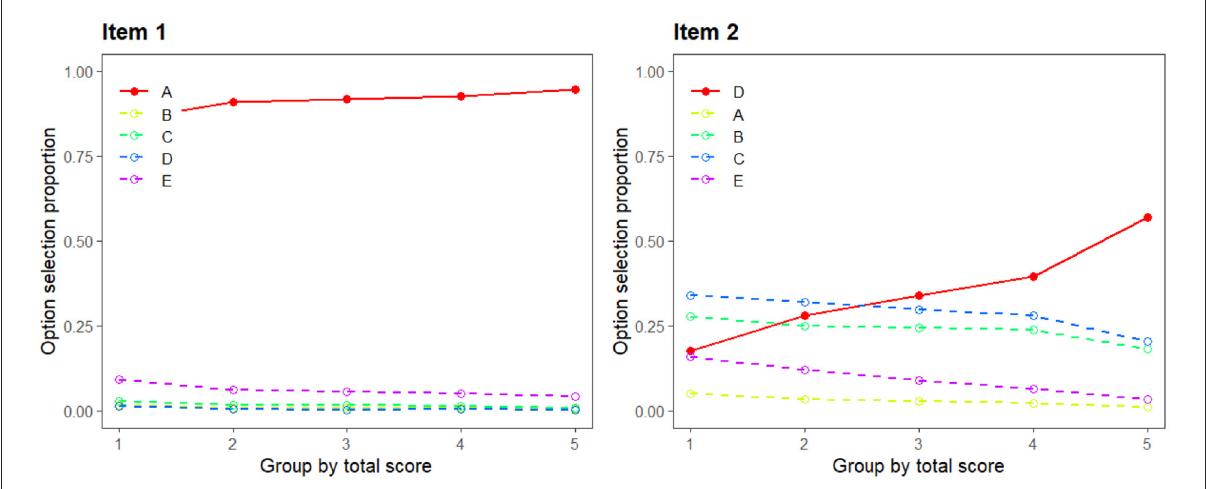
FIGURE1 Trace line plots of two